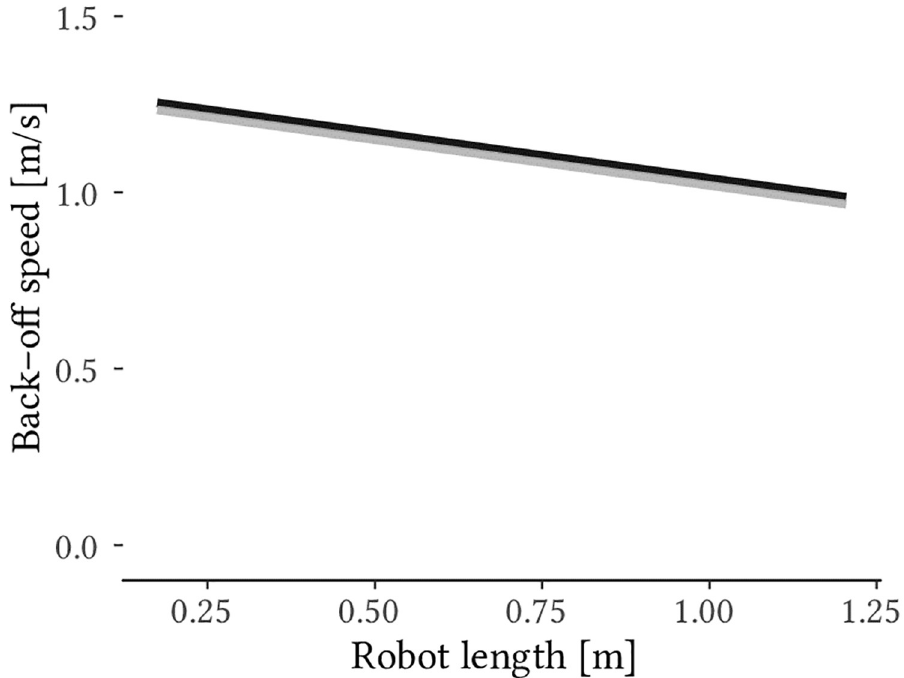
Fig 4. Predicted preferred back-off speed depending on robot size and viewpoint. The black line represents the linear equation for the frontal view, the gray line represents the linear equation for the lateral view. The number of measurements used to create the model is N =